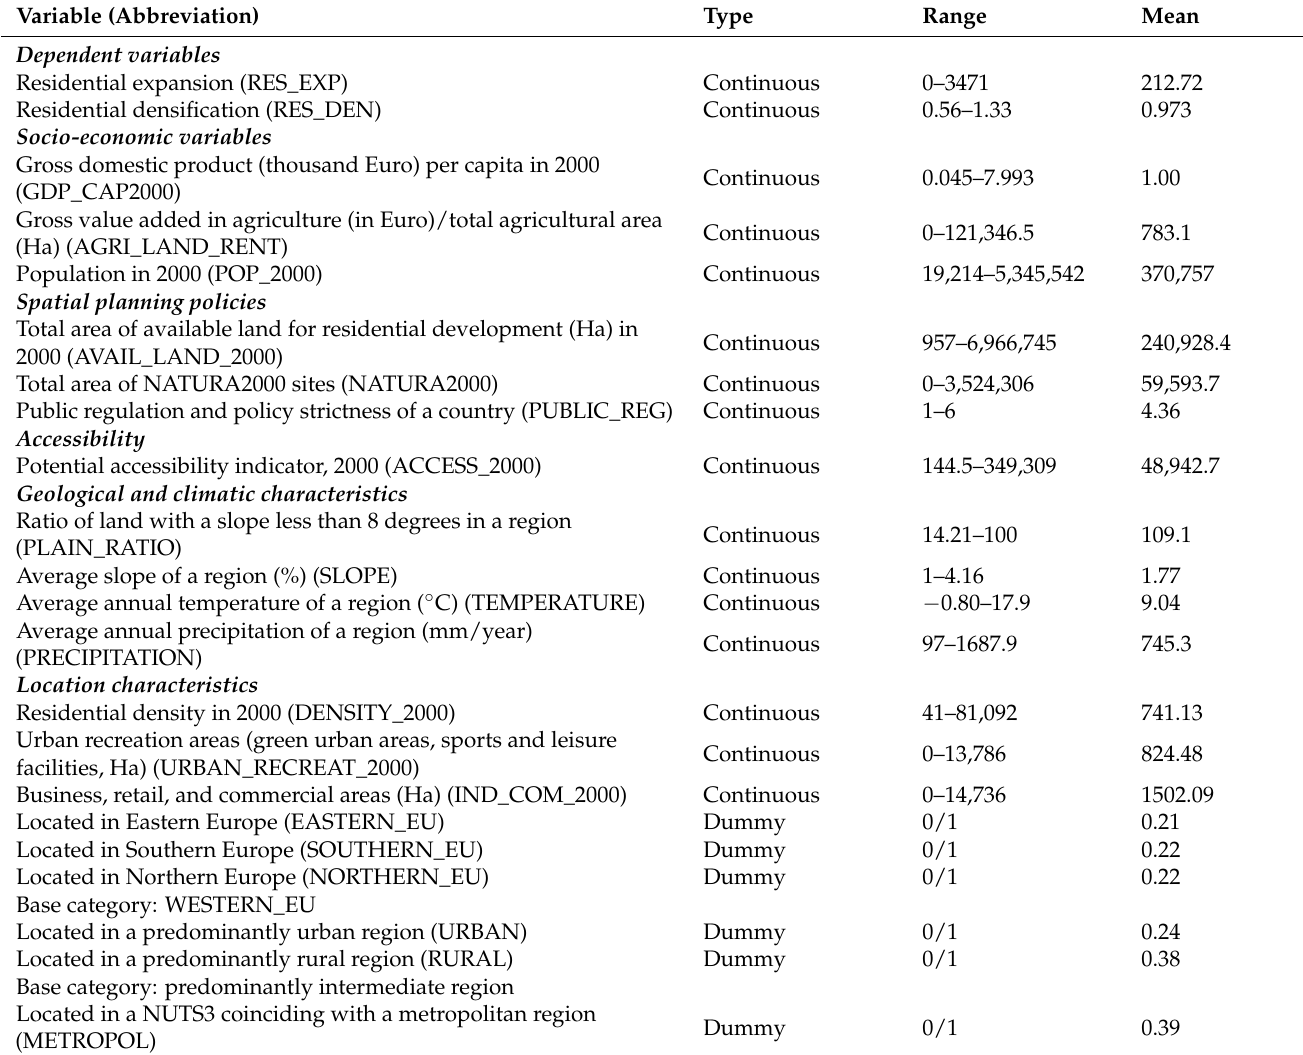
Table 1. Variables explaining density increase in residential expansion and densification areas (NUTS3